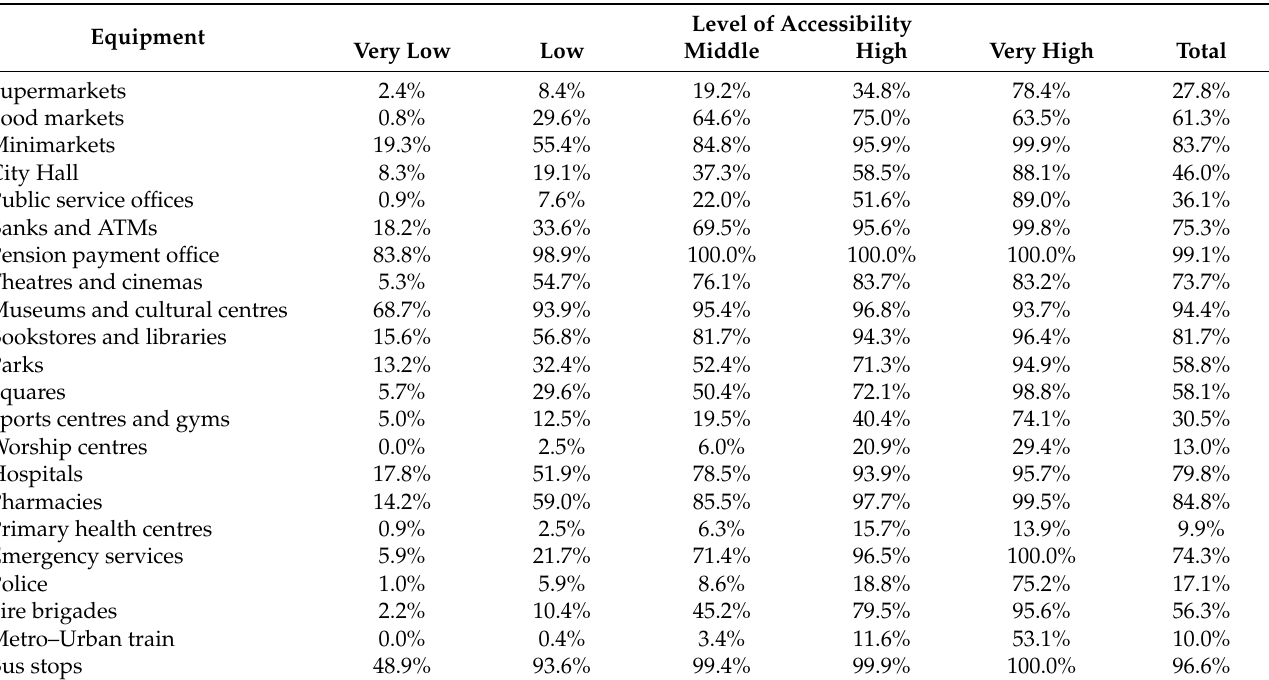
Table 3. Percentage of older people according to access to each facility, by level of